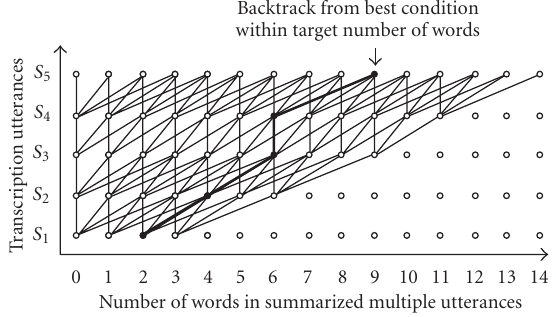
Figure 7: Example of two-level DP process to summarize multiple